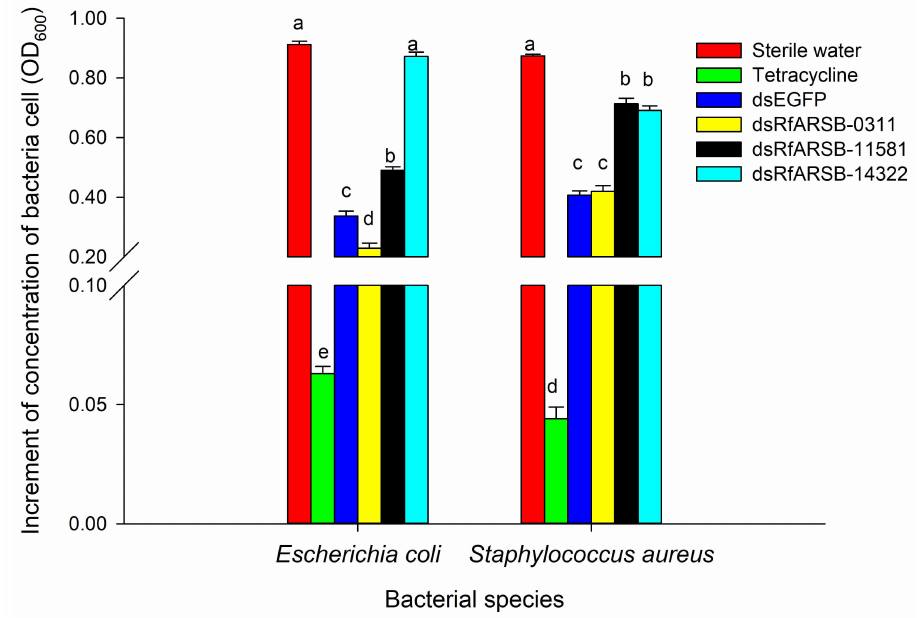
Figure 7. E ff ect of RfARSBs silencing on the antibacterial activity of oral secretions in RPW larvae at 12 h after dsRNA injection. Data are shown as the mean ± SE from ten independent biological repetitions. Di ff erent lowercase letters above the bar indicate statistically significant di ff erences among di ff erent treatments for the same indicator bacterial species at p < 0.05 (one-way ANOVA followed by Tukey’s HSD multiple comparisons).